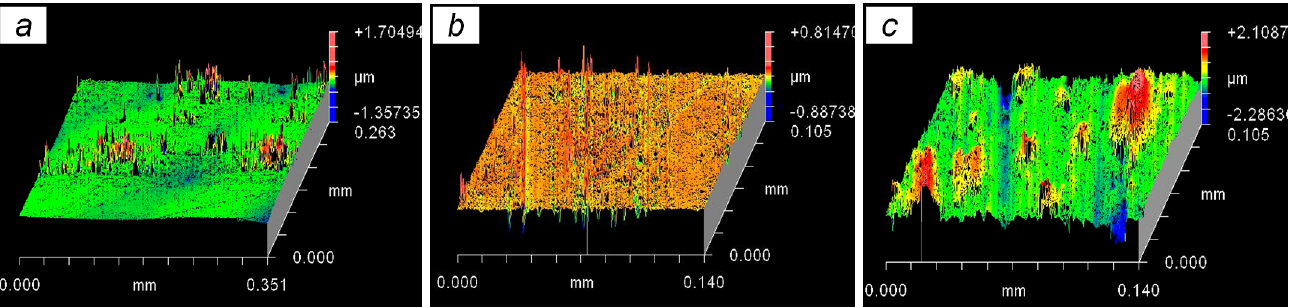
Figure 11. Surface profile of the friction track on a steel counterbody after frictional interaction with the ECAP-ed Al-30Sn sample. Sliding distance: ( a )—5 m; ( b )—20 m; ( c )—50 m. P = 1 MPa; V sl = 0.07